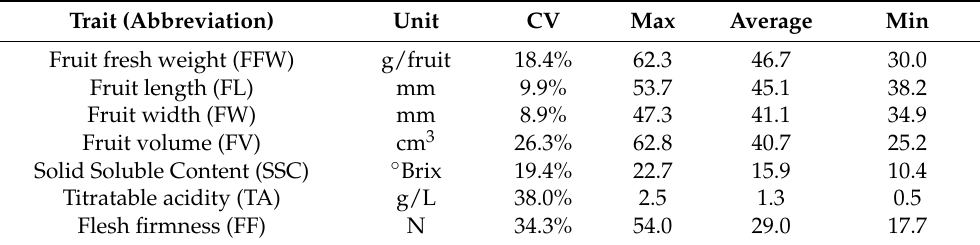
Table 2. Selected descriptive statistics for the quantitative traits of the 28 apricot landraces. For each trait, the table reports the coefficient of variation (CV) and the maximum (max), average (mean), and minimum (min)